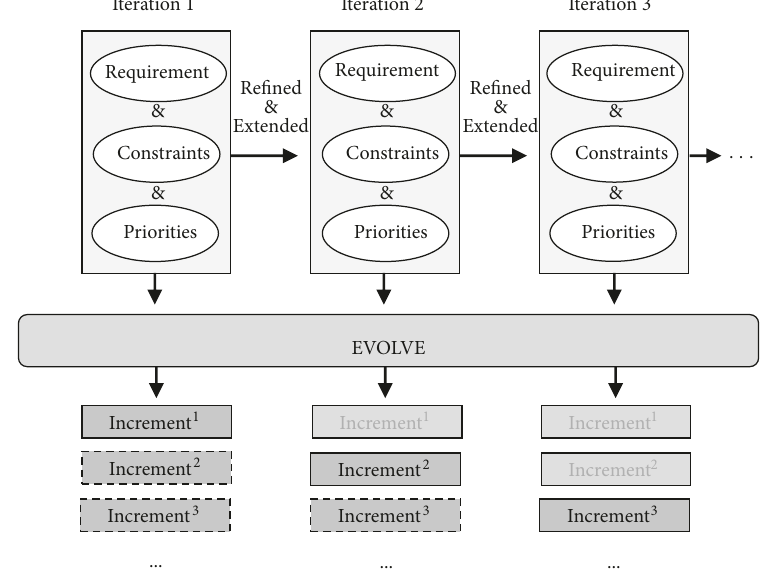
Figure 1: EVOLVE methodology